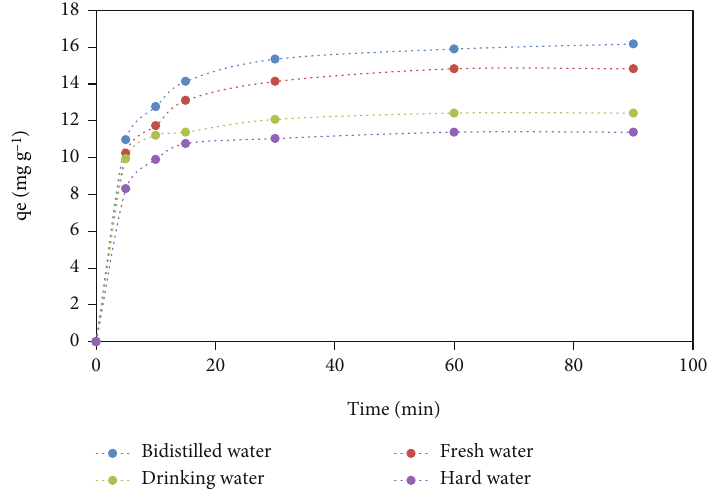
Figure 10: E ff ect of hardness and mineralization of water on the adsorption e ffi ciency of carmoisine on ND.